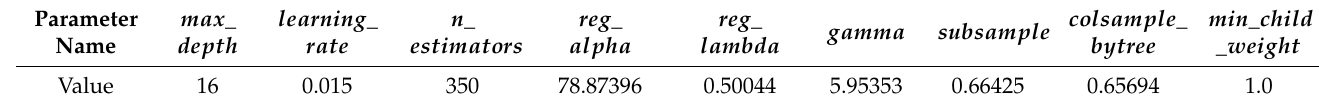
Table 1. XGBoostRegressor parameters (rounded to the 5th decimal